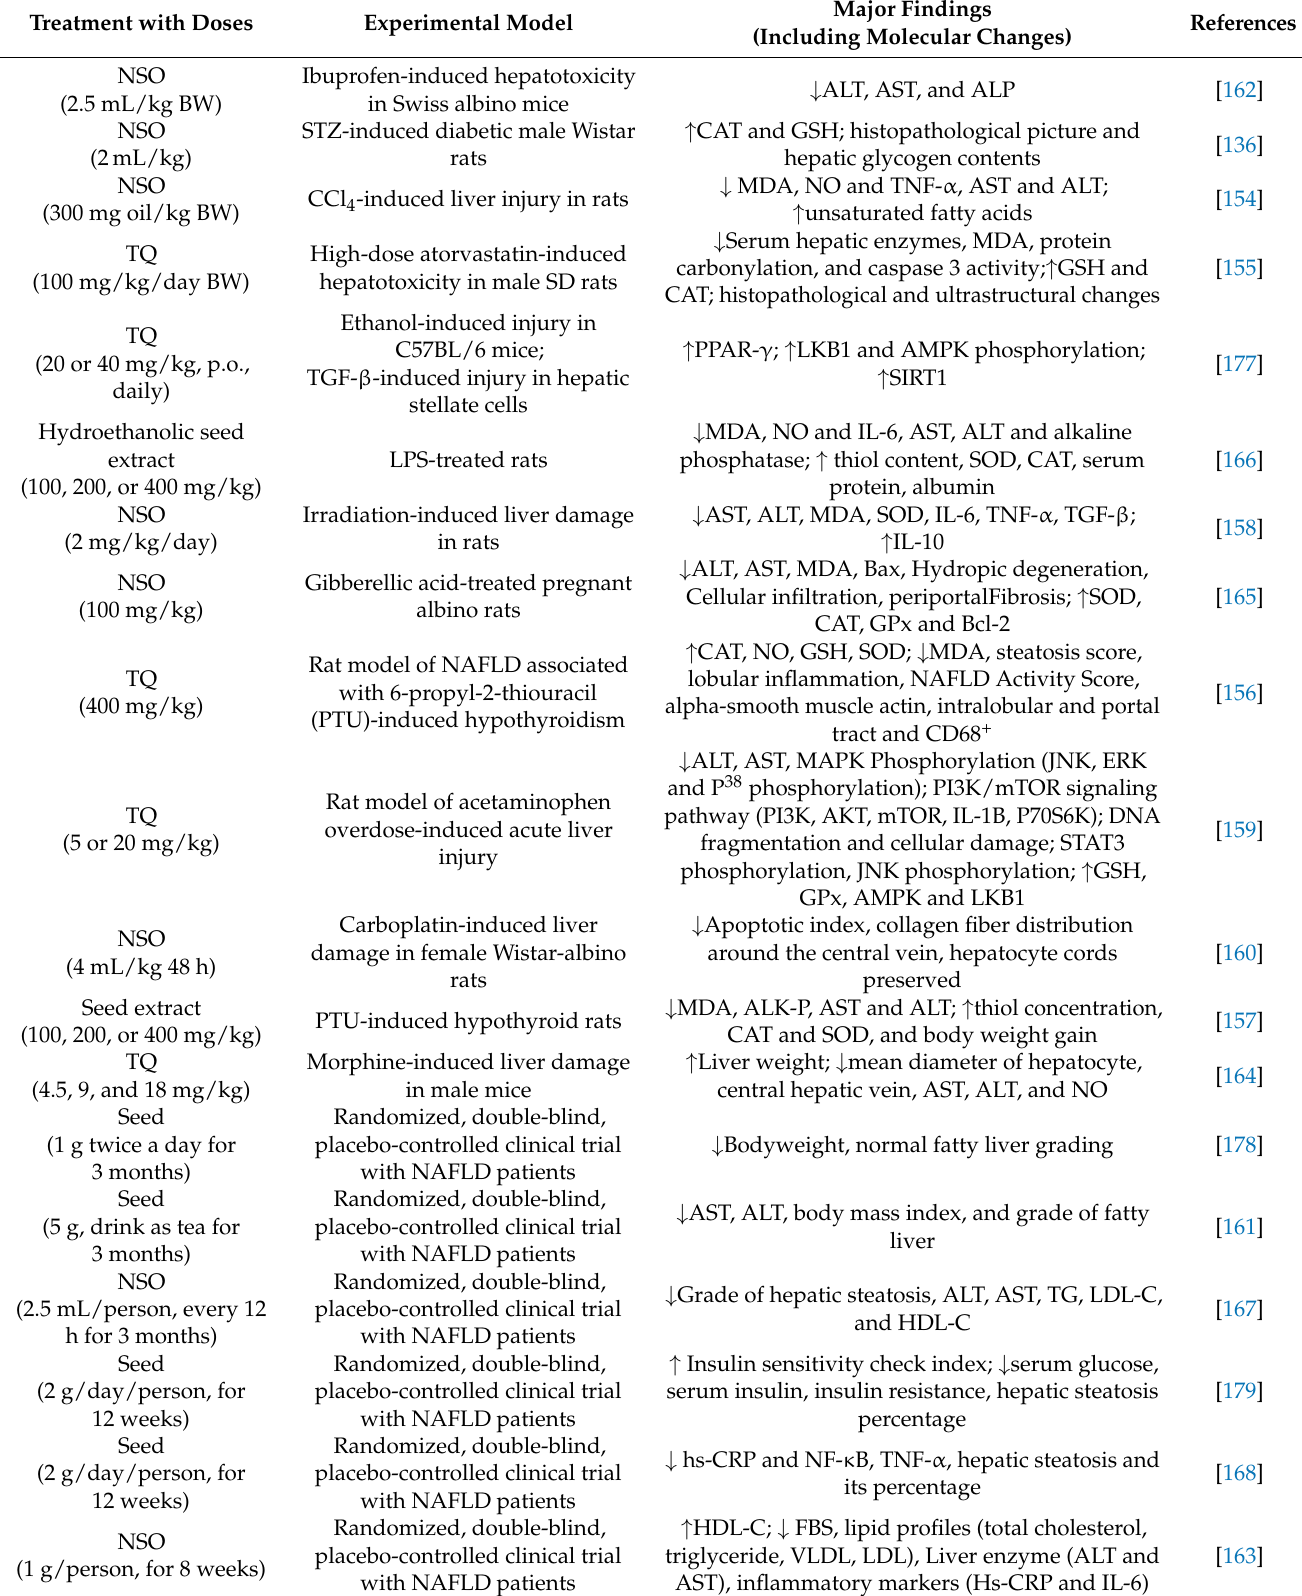
Table 6. Comprehensive summary on the hepatoprotective effects of black